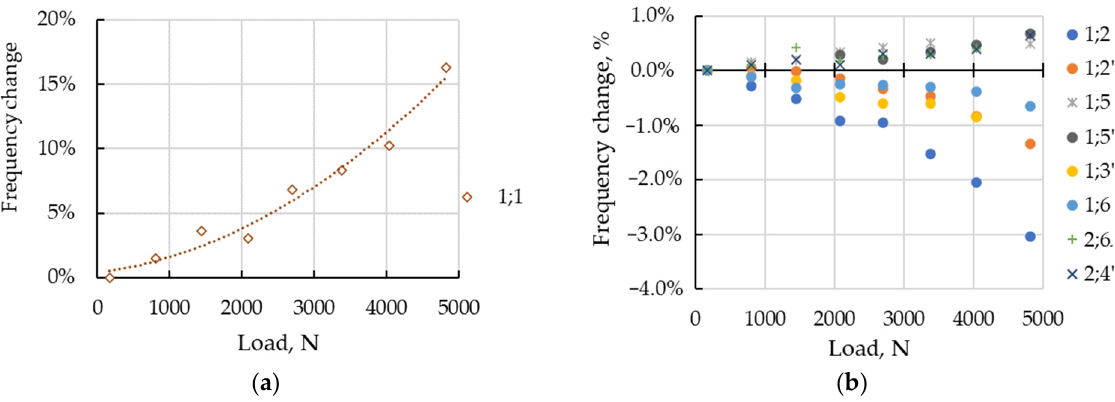
Figure 8. Frequency change under static load for Specimen 1: ( a ) bending mode (1;1); ( b ) shell modes.